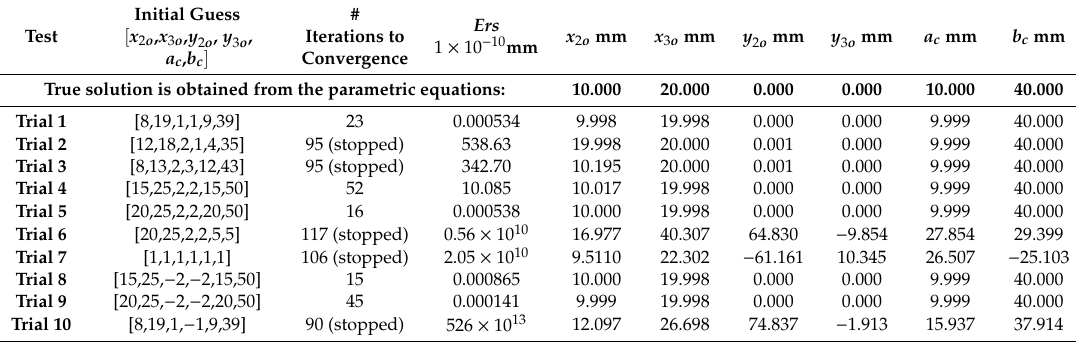
Table 2. TPFK algorithm based on the mathematical simulation: solution of the S obtained for several initial estimations.